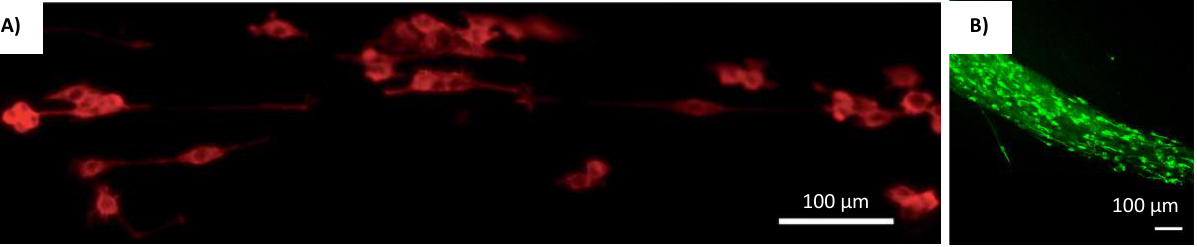
Figure 11. Cells cultured on scaffolds produced by isoelectric focusing and peptide self-assembly. ( A ) Representative fluorescent images of tubulin stained PC12 cells grown in isoelectric focused scaffolds [17]. Reprinted with permission copyright © Royal Society of Chemistry. ( B ) Flattened z-